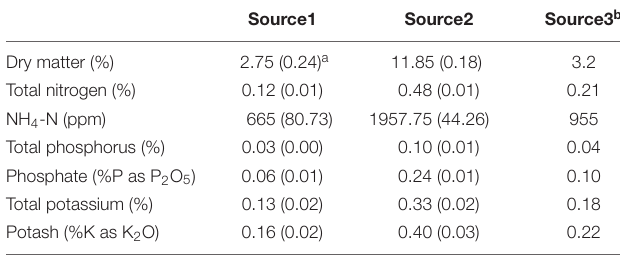
TABLE 4 | Average chemical characteristics of manure from three sources used in the corn